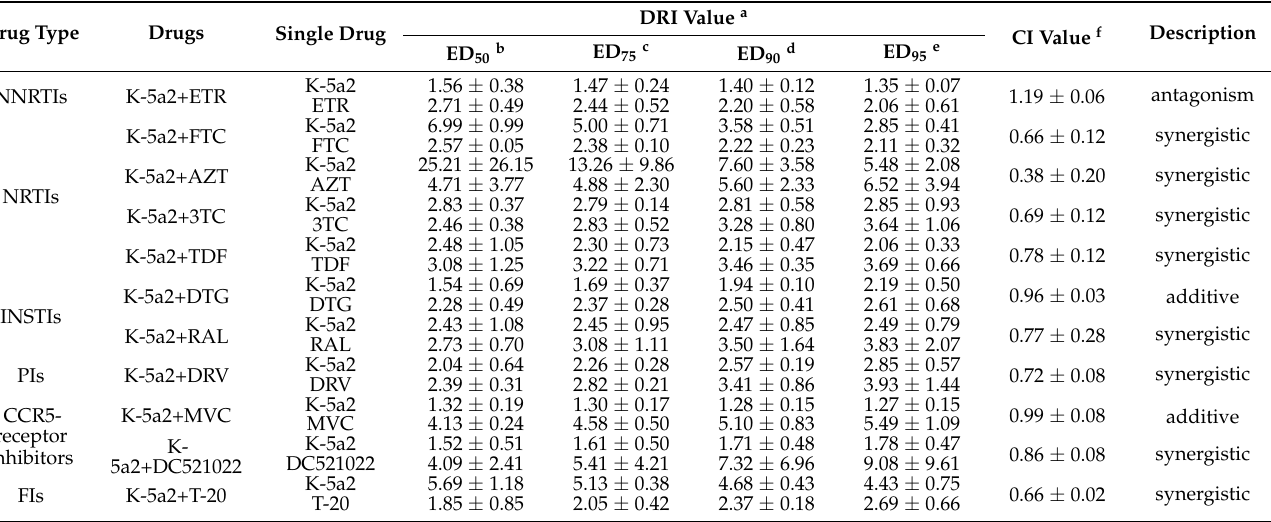
Table 3. Effect of K-5a2 combined with antiviral drugs on antiviral activity of C8166 or TZM-bl cells in